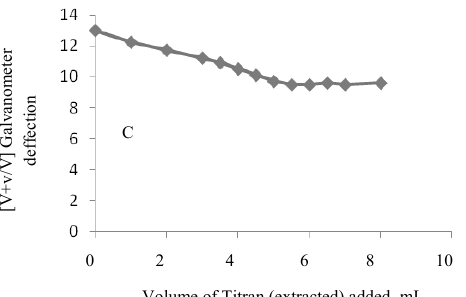
Figure 5. (A ). Amperometric titration of Cysteine (2 µM) with Crocin (1 µM) in 0.1 M NaCl, pH 5.2±0.01 ( B). Amperometric titration of crocin (1 µM) with cysteine (1 µM) in 0.1 M NaCl, pH 5.2±0.01 .( C ). Amperometric titration of cysteine (1 µM) with saffron extract soluteon containing crocin in 0.1 M NaCl, pH =5.2±0.01.